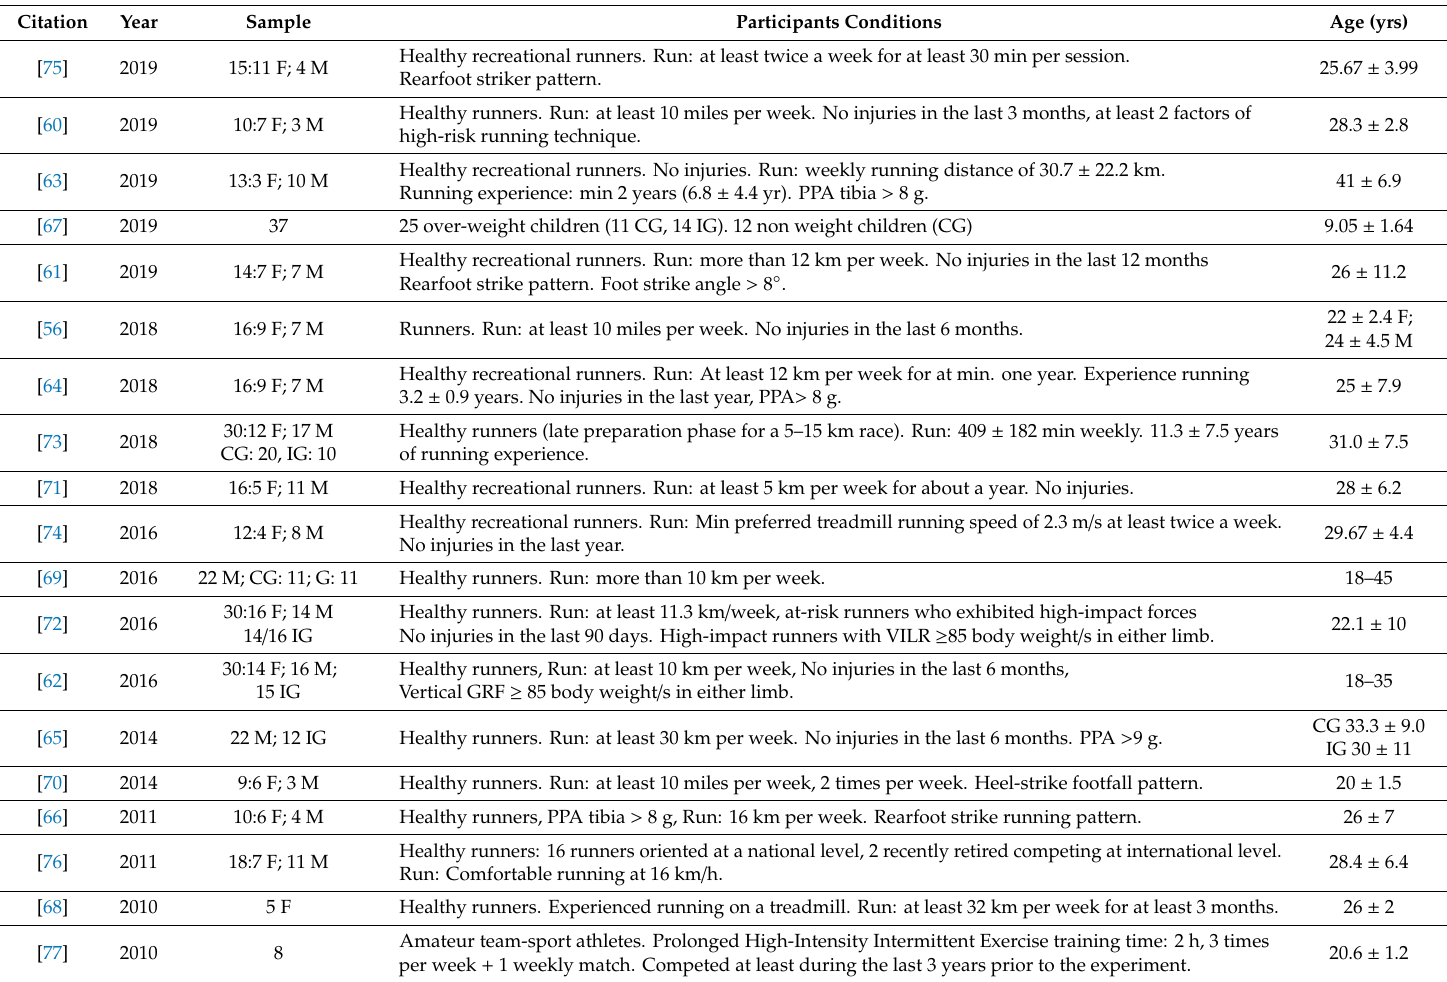
Table 2. Study identification and sample